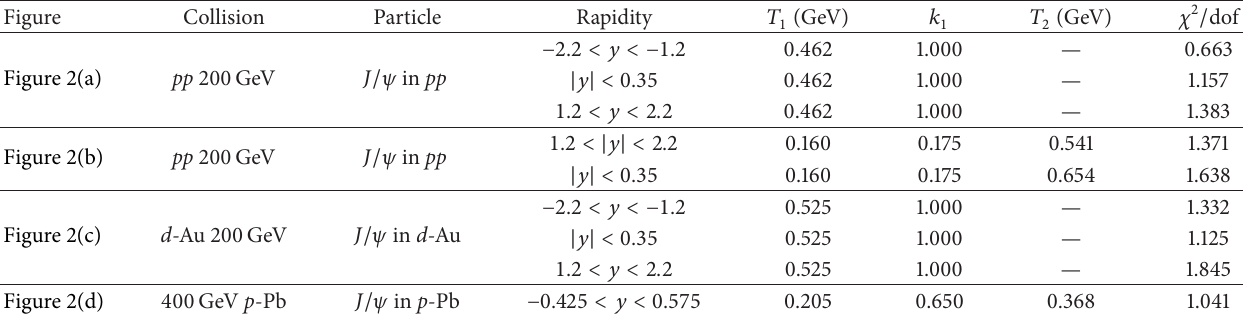
Table 2: Parameter values corresponding to the curves in Figure 2.